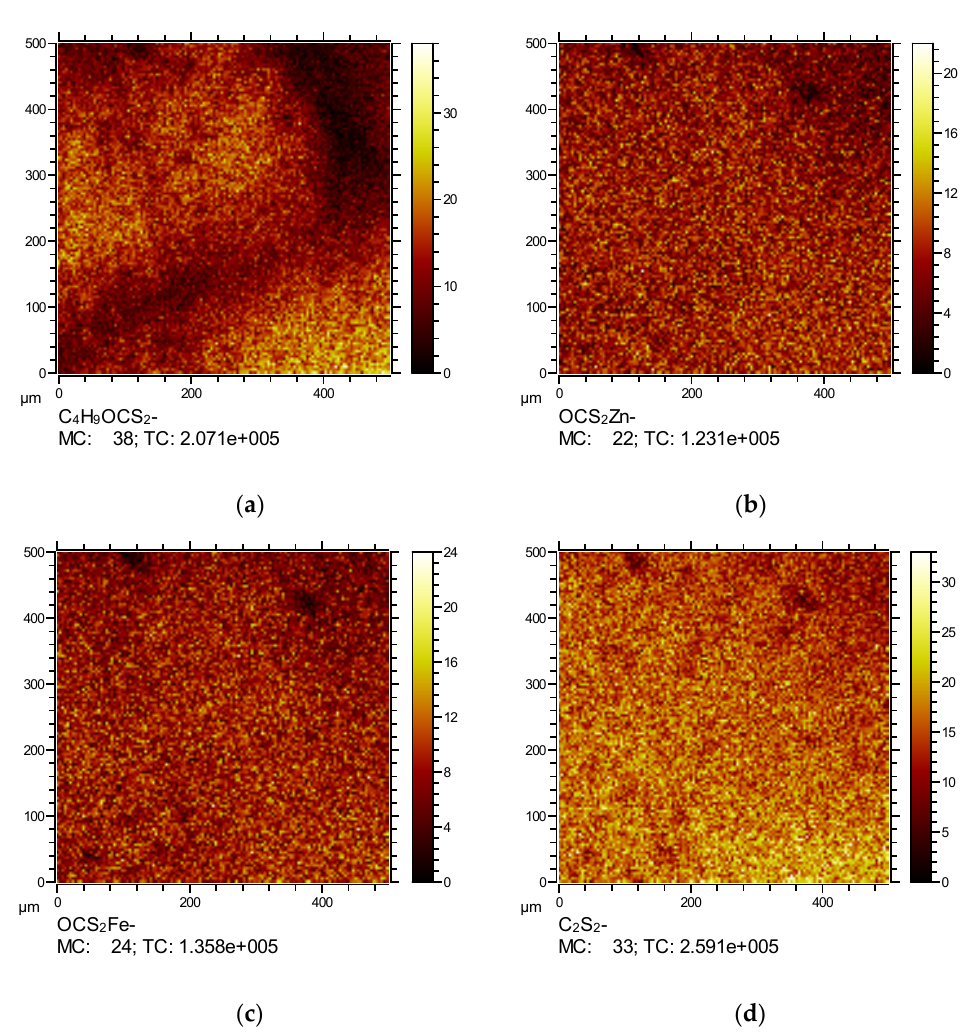
Figure 6. ToF-SIMS negative-ion images of BX absorbed marmatite surface at pH 6.5. ( a ): C 4 H 9 OCS 2− ; ( b ): OCS 2 Zn − ; ( c ): OCS 2 Fe − ; ( d ): C 2 S 2 −